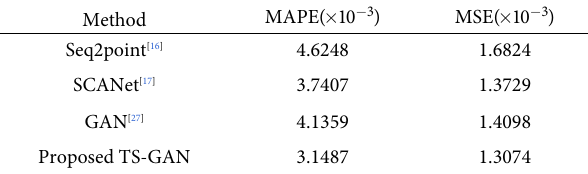
Table 2 Regression-oriented metrics for IES